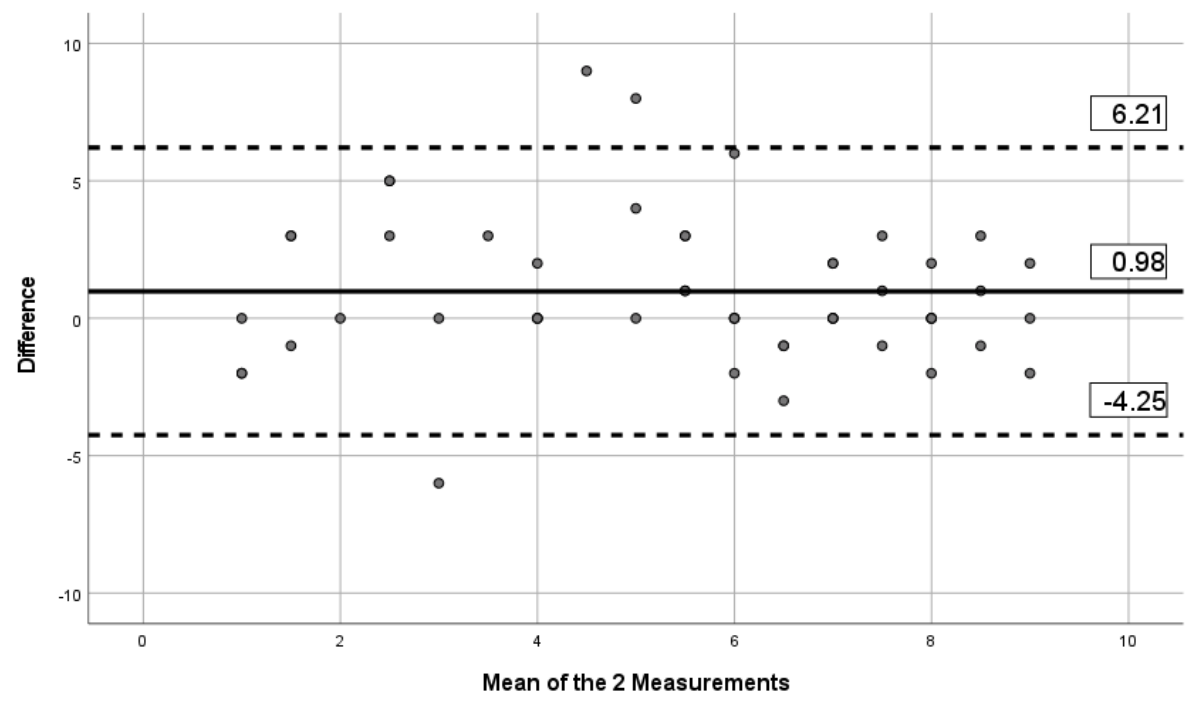
Figure 6. Bland-Altman limits for the issue of fear of movement between the 2 assessments using the app.